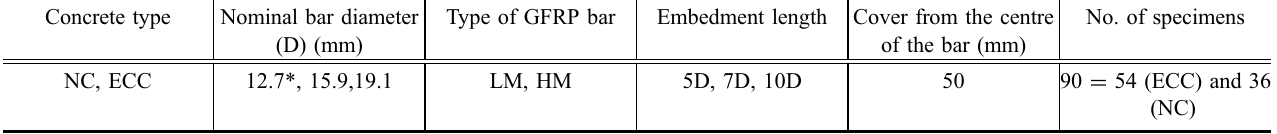
Table 1 RILEM beam bond test variable parameters, specimen details and concrete properties.